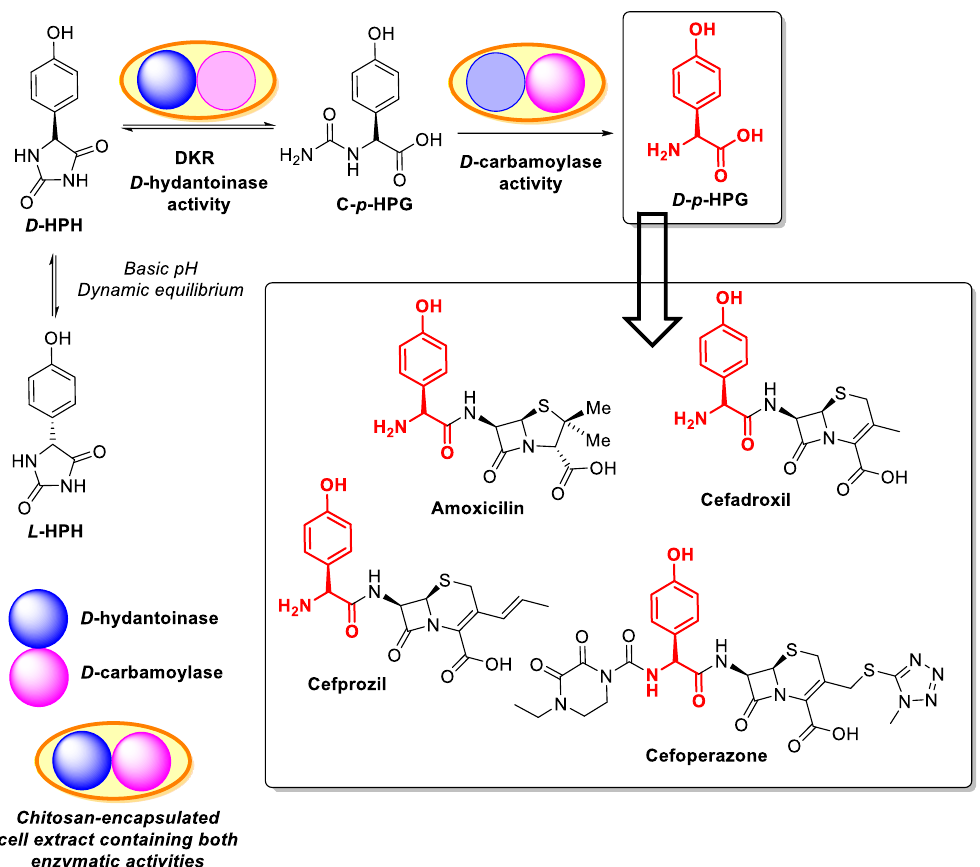
Figure 6. Schematic representation of the production of p -hydroxyphenylglycine (p-HPG) starting from a racemic mixture of p -hydroxyphenyl hydantoin (HPH) using a multi-enzyme system containing immobilized D -hydantoinase and D -carbamoylase.